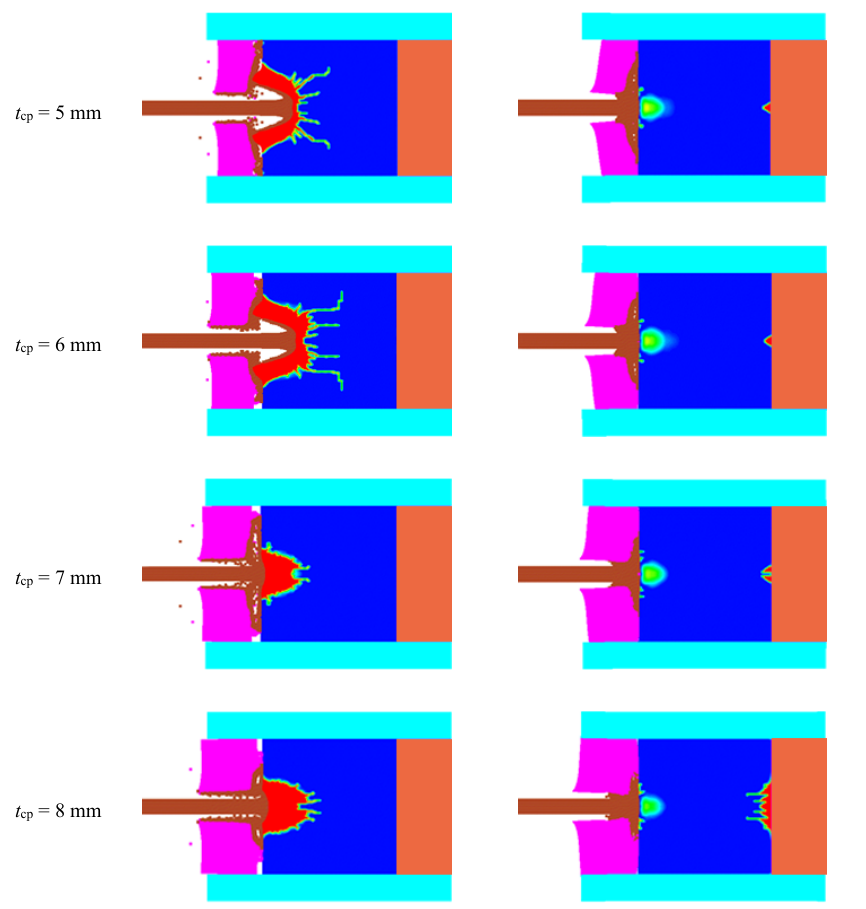
Figure 8. Computed results for tungsten rods impacting confined SiC targets with different cover plates. The impact velocity is 1400 m/s and the dwell time, T d , is 26 μ s.